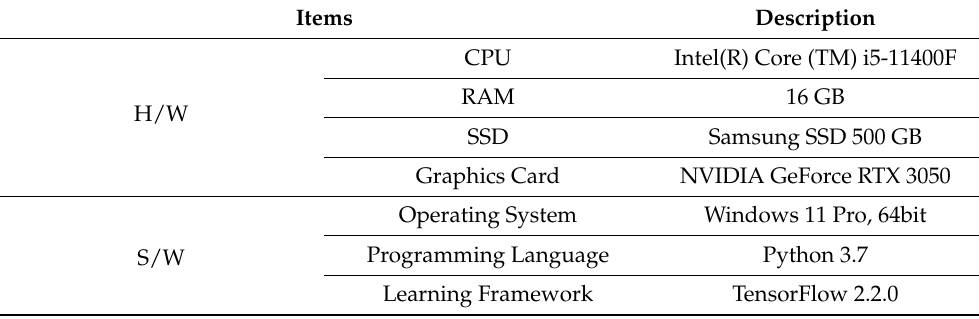
Table 1. Workstation mainframe hardware and software.